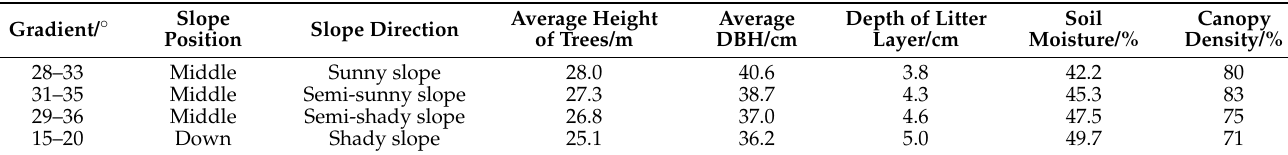
Table 2. Stand characteristics of Castanopsis hystrix sample plots on slopes of different